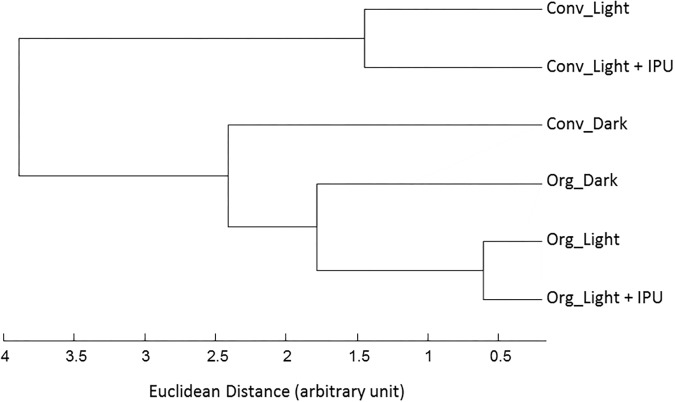
A hierarchical cluster analysis on Mid-Infrared spectra (data ranged from 1500 to 900 cm−1) of bound exopolysaccharides samples extracted from soil aggregates of microcosms at the end of incubations (day 50) under the different conditions (Dark, Light, Light + IPU, see Table 1 for acronym description). “Org” is for Organic cropping system and “Conv” is for Conventional cropping systems.